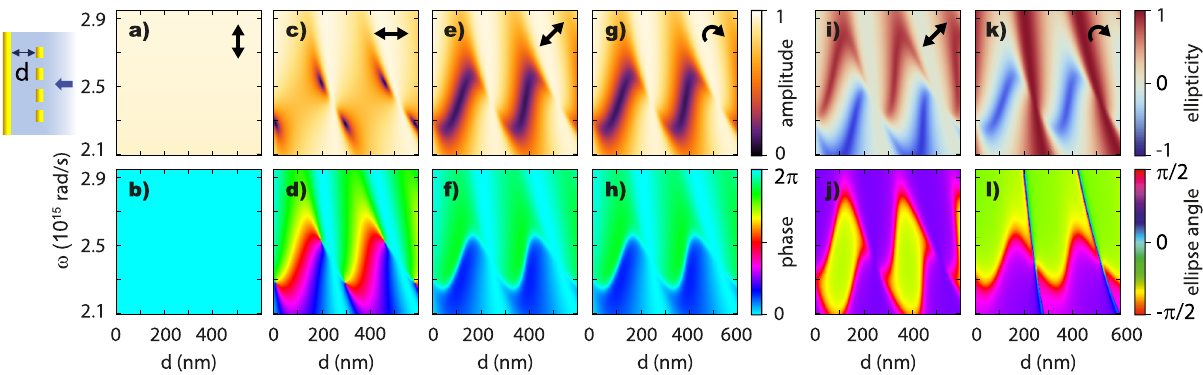
Figure 4: (a – h) Polarization dependent amplitude and phase response of Salisbury screens in reflection, for a lattice of pitch 200 nm (other antennaparameterstakenthesameasinFigure2)anda backre fl ectorof thickness50nm.Thetop rightarrowsdenotetheinputpolarization, and results shown are for the co-polarized detection channel. (a and b) polarization orthogonal to the antenna resonance axis, (c and d) polarization alignedwith antennaresonanceaxis(i.e., plotsidentical to Figure 2g andl), (e and f) diagonal and (g andh) right handed circular (RHC)polarization.(i – l)Ellipticityparameters ϵ and α ,ameasureofcircularpolarizationandorientationrespectively,forthecasesofdiagonal and RHC input polarization. Diagonal and RHC plots are equivalent in amplitude and phase (e – h) for the co-polarized re fl ected channel, but entirely distinct in ellipticity (i –